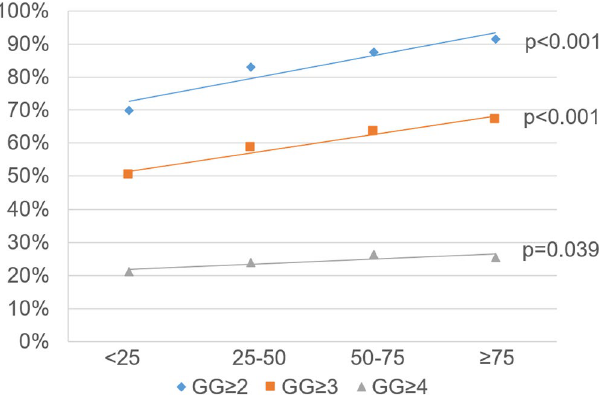
Figure 1. Percentage of GG ≥ 2, GG ≥ 3, and GG ≥ 4 histopathology by PRS percentile.